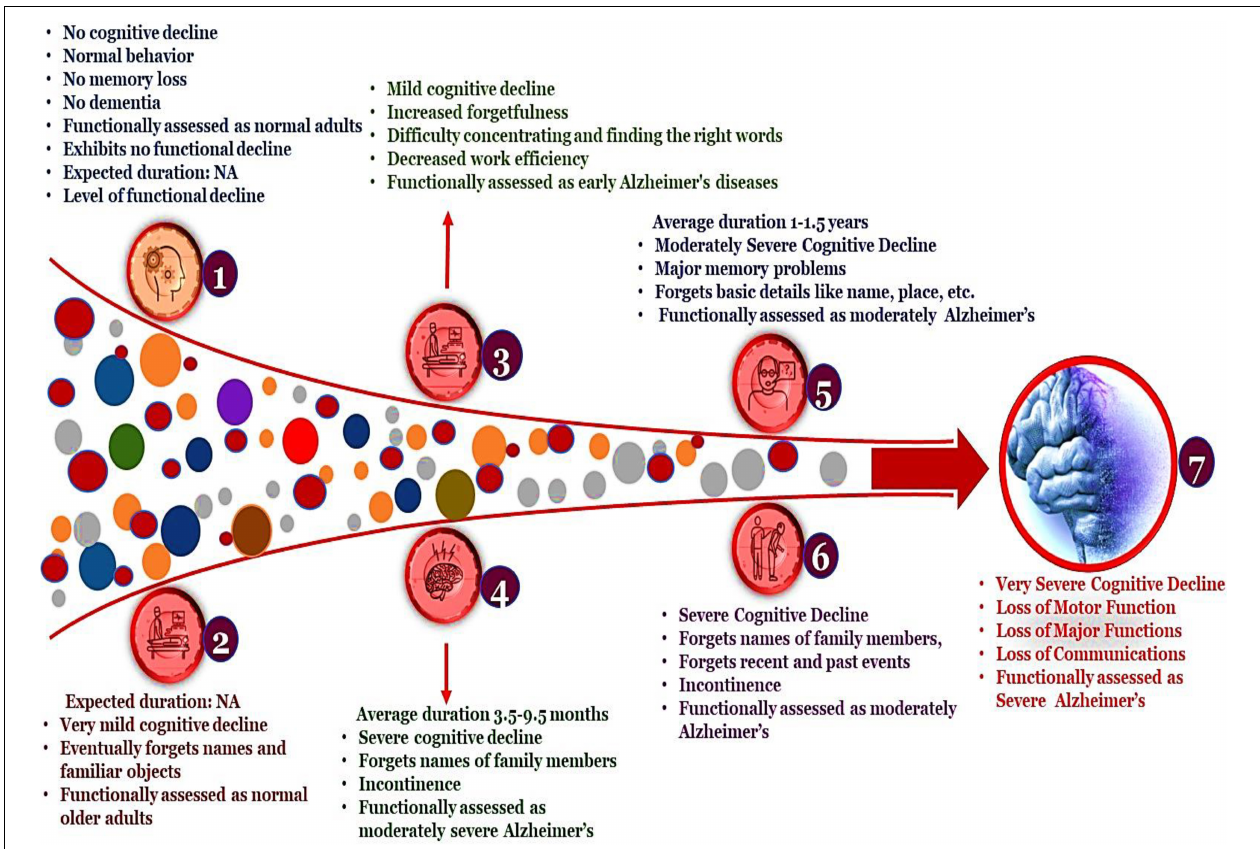
FIGURE 1 | Different stages of Alzheimer’s disease. The above classification is based on the Global Deterioration Scale/Reisberg Scale for rating dementia. This classification of AD mainly relies on the Functional Assessment Staging Test (FAST) wherein the individual is examined for their cognitive decline depending on their aptness to engage in daily